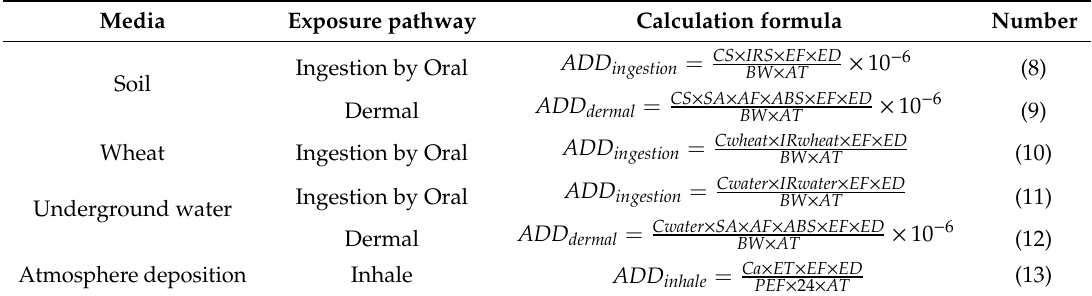
Table 1. Calculation formula of daily intake via various exposure pathways in multiple